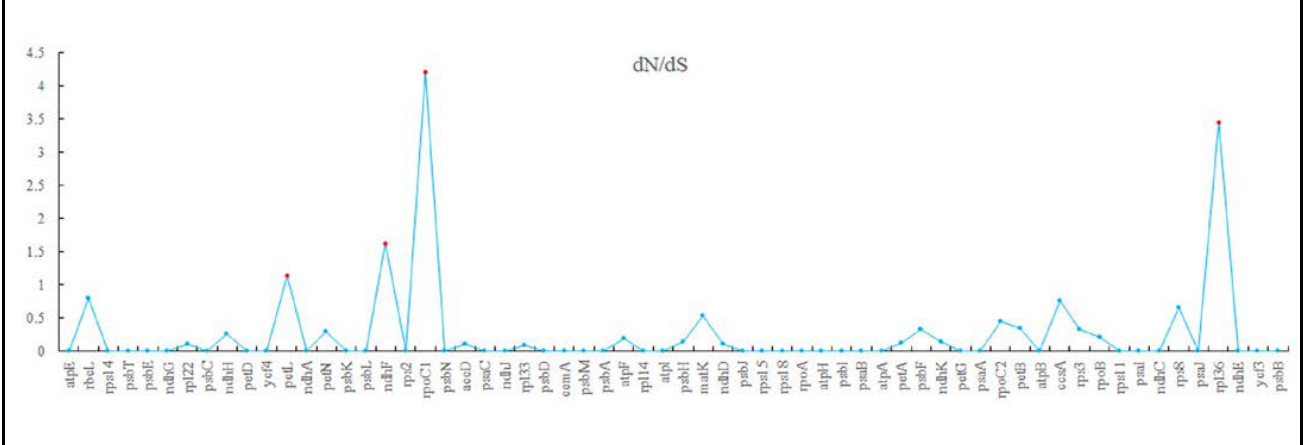
Figure 7. Positive selection analysis among Prunus species. The abscissa denotes the gene name, and the ordinate denotes the dN/dS ratio value.